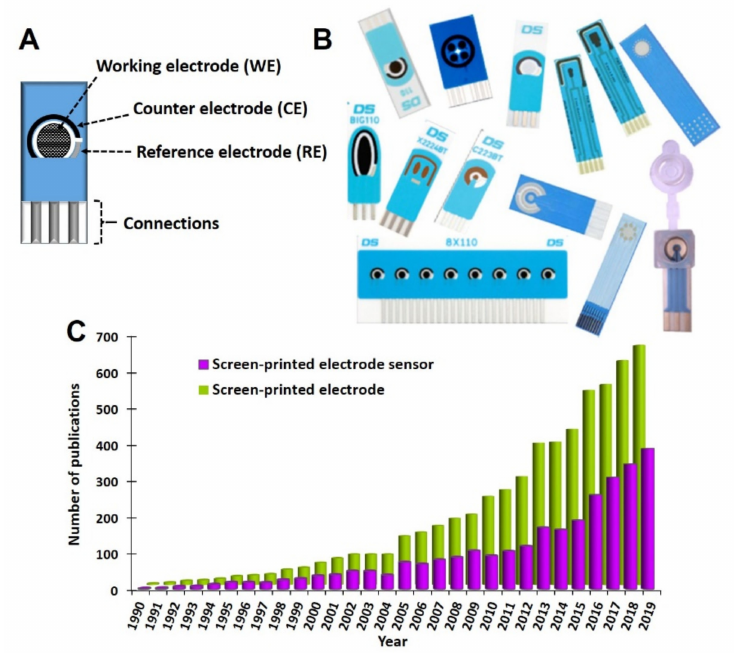
Figure 2. ( A ) Scheme of the most common configuration of a screen-printed electrode. ( B ) Examples of commercial screen-printed electrodes with di ff erent configurations and designs. Reproduced from [19] with permission from Wiley. ( C ) Number of publications per year when searching “screen-printed electrode” and “screen-printed electrode sensor” in Scopus database for the last 30 years